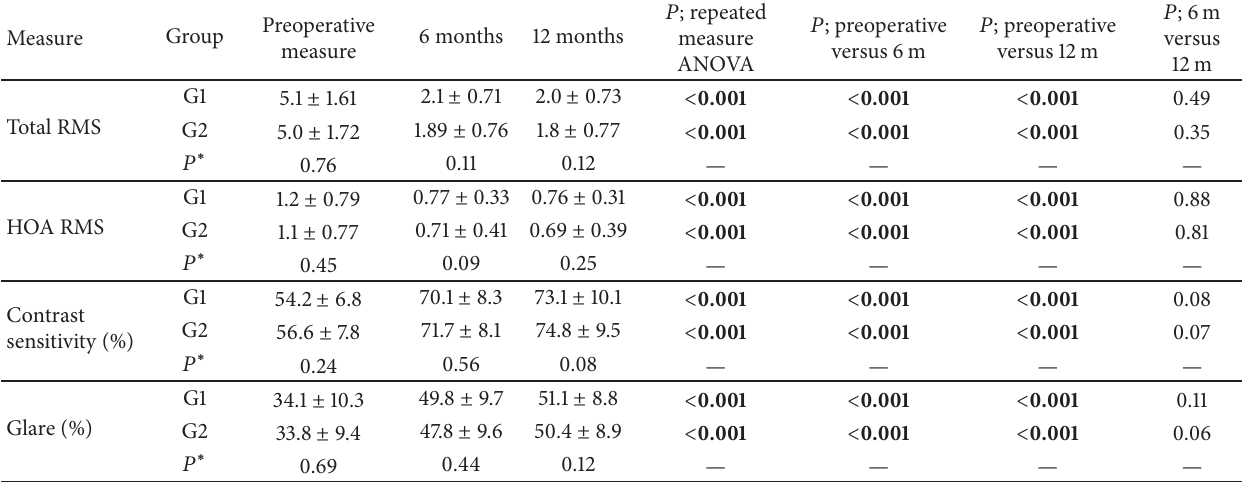
Table 5: Preoperative and postoperative aberrometric parameters and mesopic vision testing results (mean ± SD) in the 2 studied groups 6 months and 12 months following the full procedure.